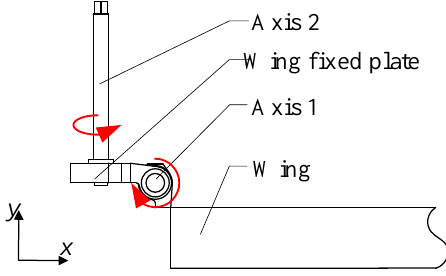
Figure 3. Schematic diagram of folding wing deployment.